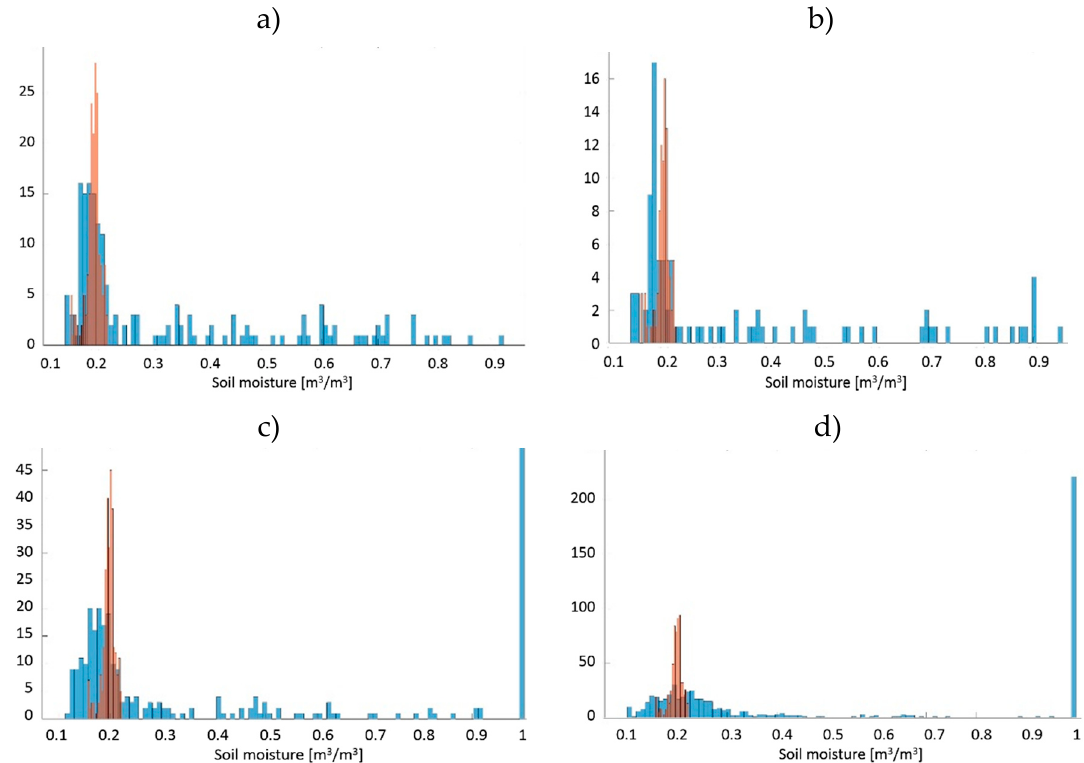
Figure 17. Histograms of ARIEL (brown) and GNSS-R (blue) retrieved SM using surface roughness correction as a function of the incidence angles: ( a ) from 0 ° to 15 ° , ( b ) from 15 ° to 30 ° , ( c ) from 30 ° to 45 ° , and ( d ) from 45 ° to 60 ° .